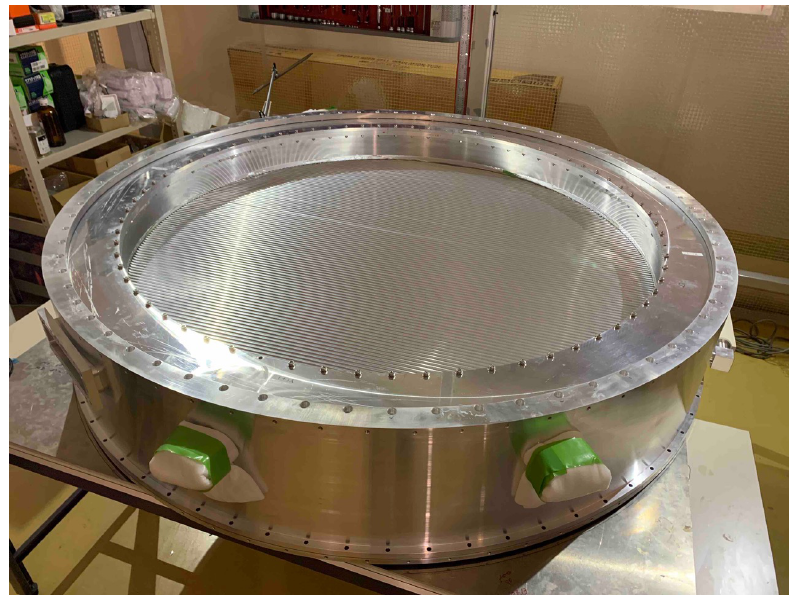
Figure 8. Photograph of the straw tracker being assembled (first